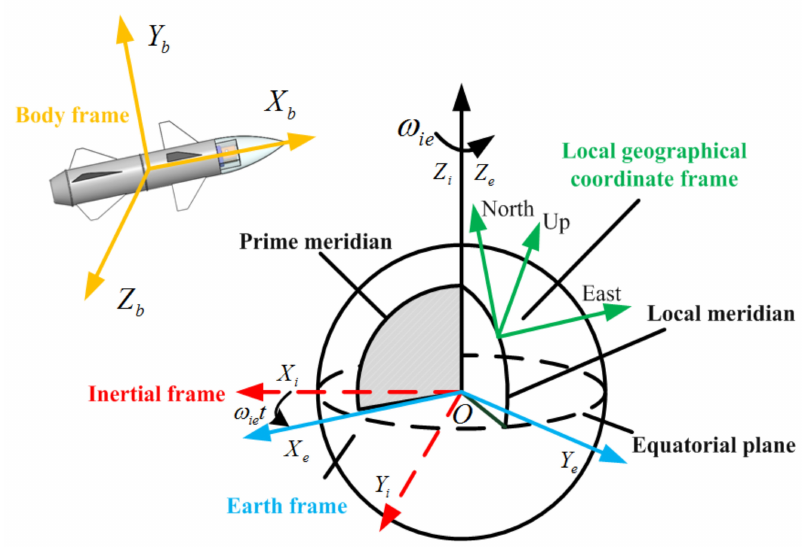
Figure 2. Diagram of each coordinate